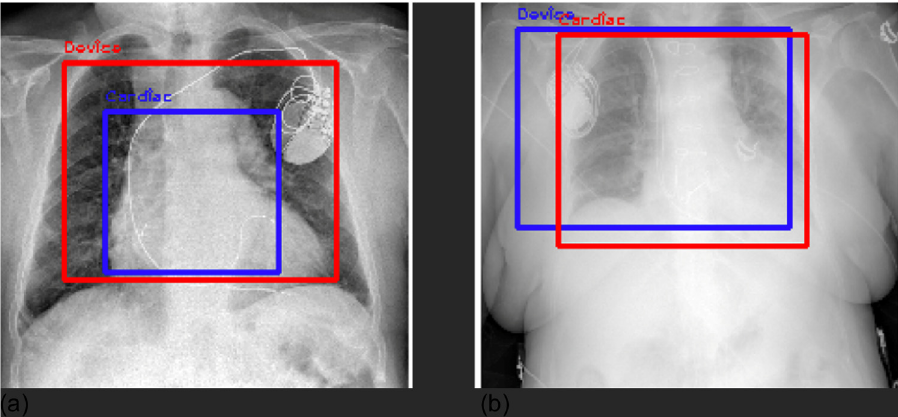
Figure 8. Superimposition of bounding boxes for cardiac (panel a , cardiac in blue and device in red) and device (panel b , device in blue and cardiac in red) outcomes for two examples.